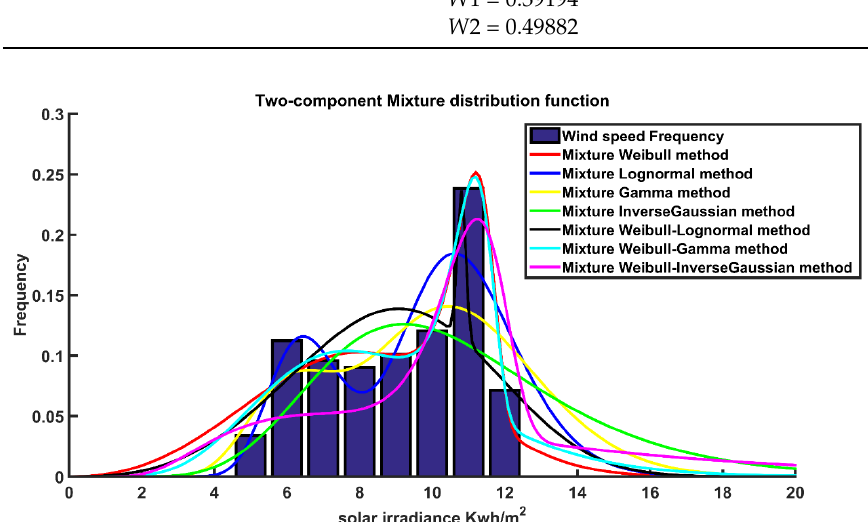
Figure 6. The two-component mixture distribution functions in the solar irradiance modeling.